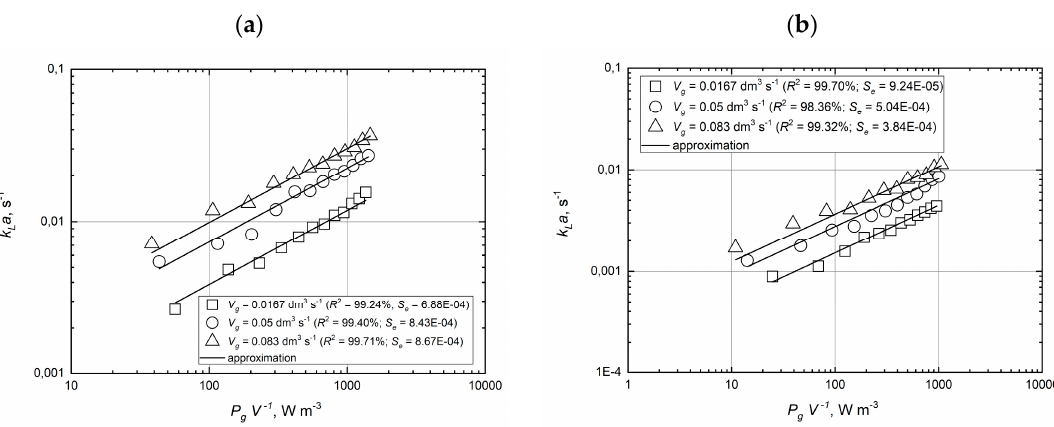
Figure 12. The comparison of the volumetric mass transfer coefficient at various gas flow rates for the tested BioFlo ® 115 ( a ) and BioFlo ® 415 ( b ) bioreactors.